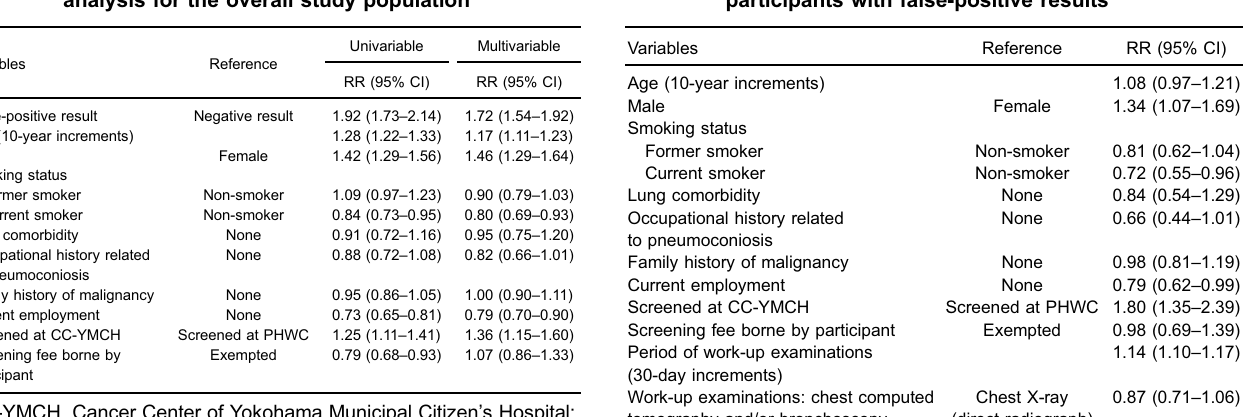
Table 2. Predictors of participation in subsequent screening based on univariable and multivariable regression analysis for the overall study